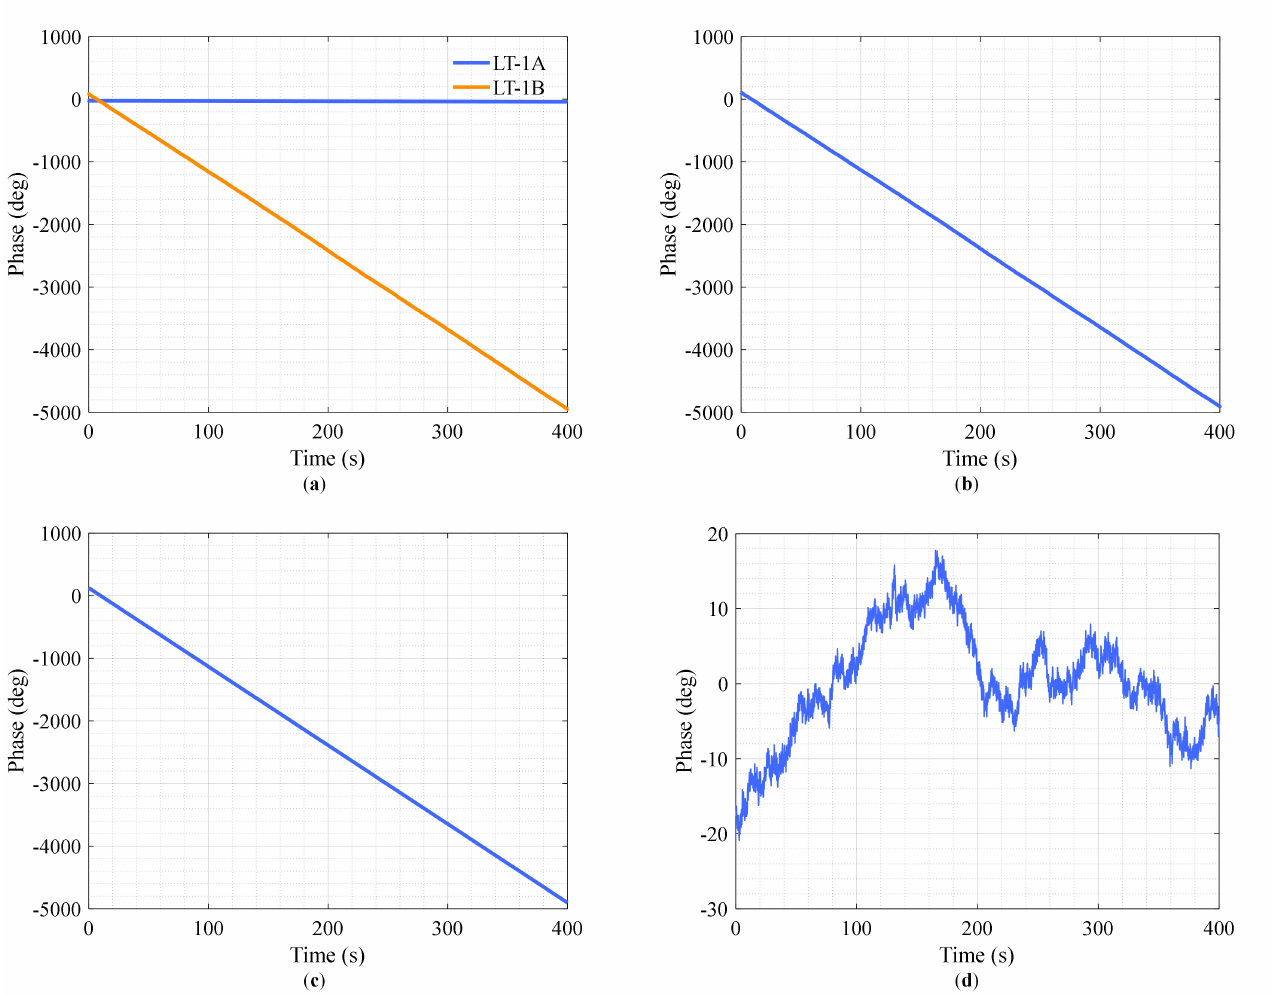
Figure 5. Imaging phase. ( a ) Imaging phase of LT-1A ϕ a and LT-1B ϕ b . ( b ) Imaging phase difference ϕ dif between ϕ a and ϕ b . ( c ) Linear term ϕ l